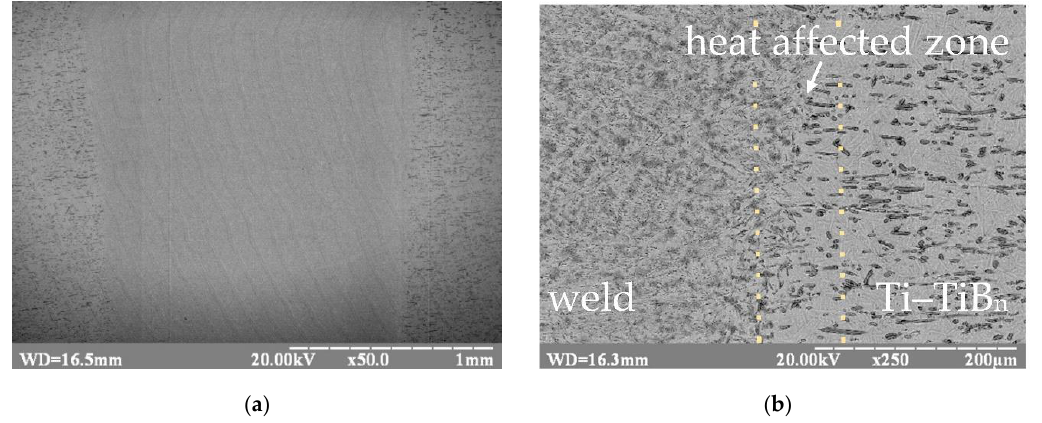
Figure 3. Welded joint produced by electron-beam welding of Ti-TiB n samples: ( a ) overview; ( b) microstructure of weld metal, heat-affected zone (HAZ) and base metal.